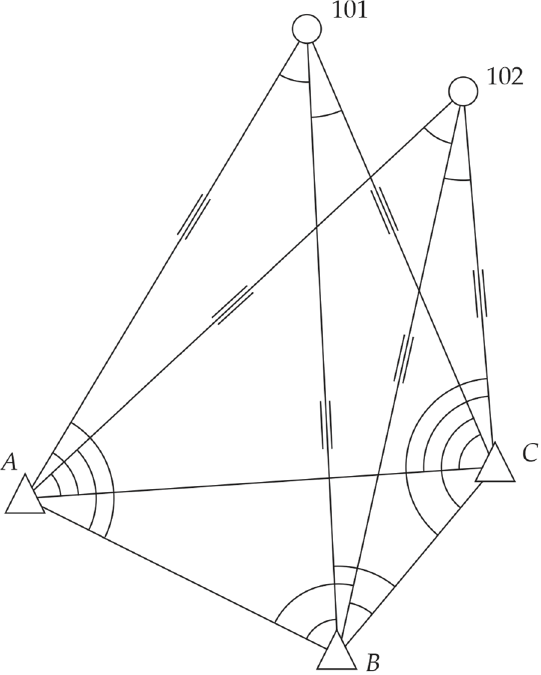
Figure 6. Simulated horizontal network.